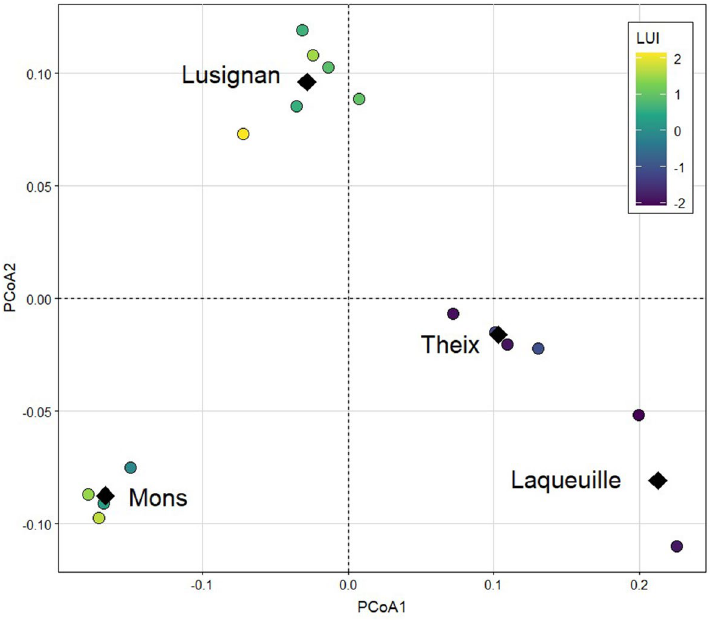
Figure 3. Principal Coordinates Analysis based on food web dissimilarities for interaction networks constructed with Operational Taxonomic Units (OTUs) in experimental fields. Colours illustrate the gradient of land-use intensity (LUI) across experimental fields. Black diamonds represent the barycenter of each study